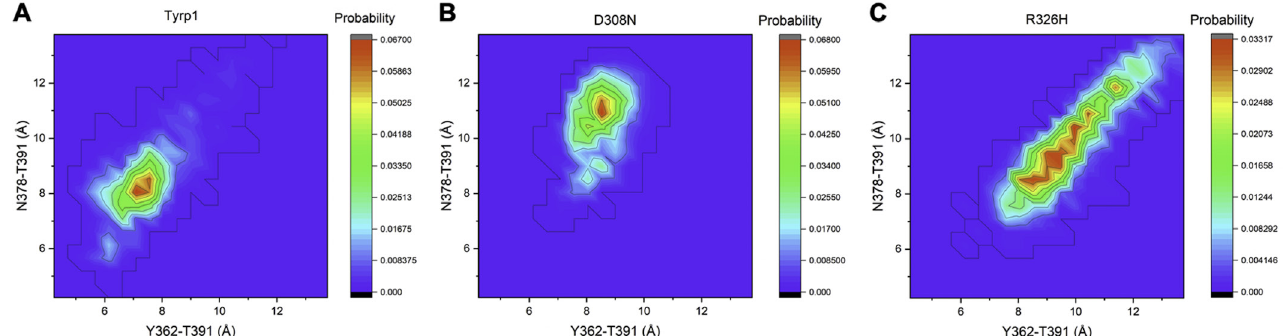
Figure 5. Free energy landscapes of Tyrp1 ( A ), D308N ( B ), and R326H ( C ). The peak of Tyrp1 was centered around (7.10, 8.05) Å with a probability of 0.067. The peak of D308N was centered around (8.52, 10.90) Å with a probability of 0.068. The peak of R326H was centered around (8.52, 8.52) Å with a probability of 0.032. The binding sites of Tyrp1 and D308N appear to be better defined than R326H’s binding site.